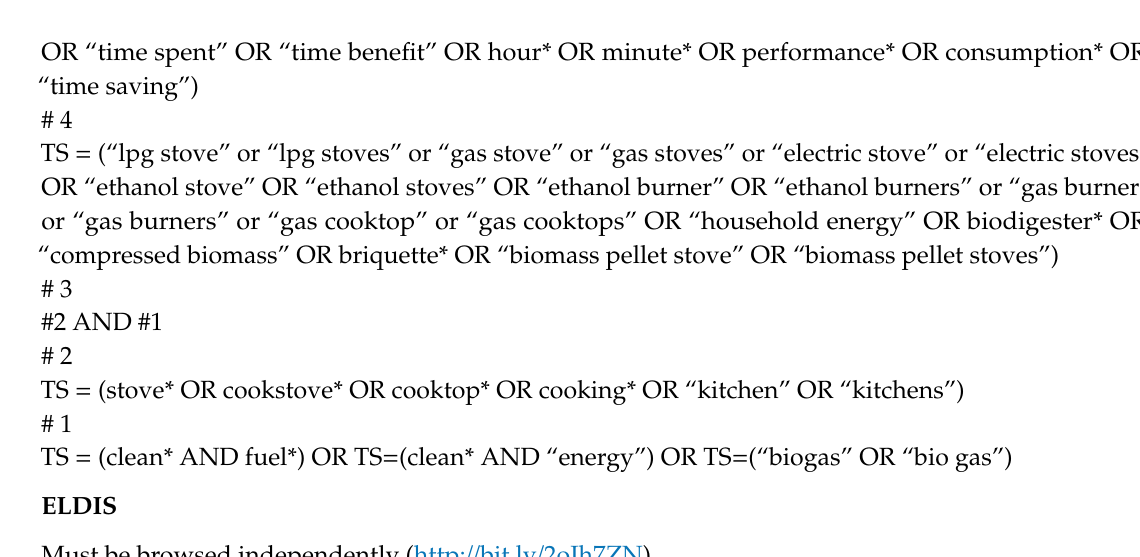
Must be browsed independently (http: // bit.ly / 2oIh7ZN).